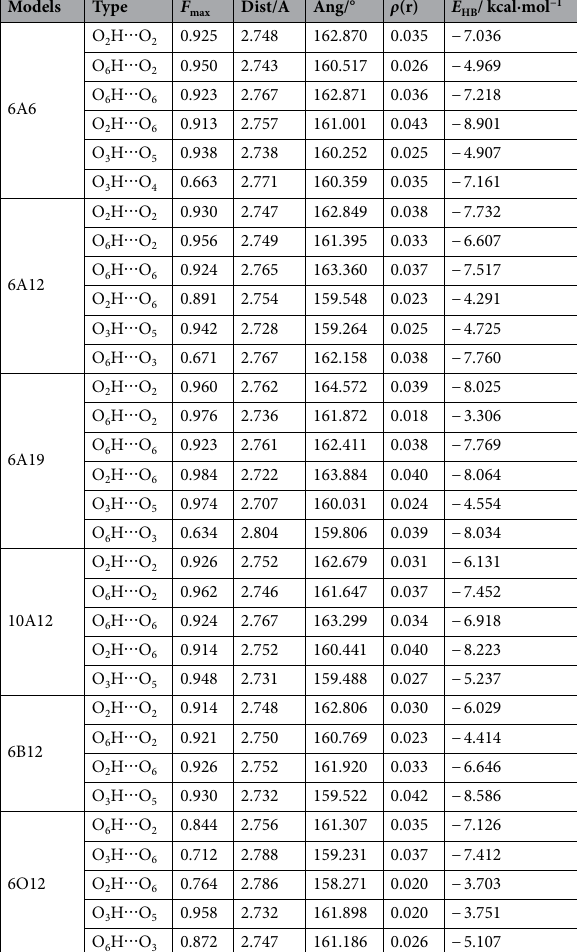
Table 2. Details of HBs in the sample where the fraction of an individual HB is highest among all samples for all the six models. The HBs type, fraction ( F max ) and O ⋯ O distance (Dist), HB angle (Ang), the electron density ρ (r) and corresponding HBs strength ( E HB ) are included.